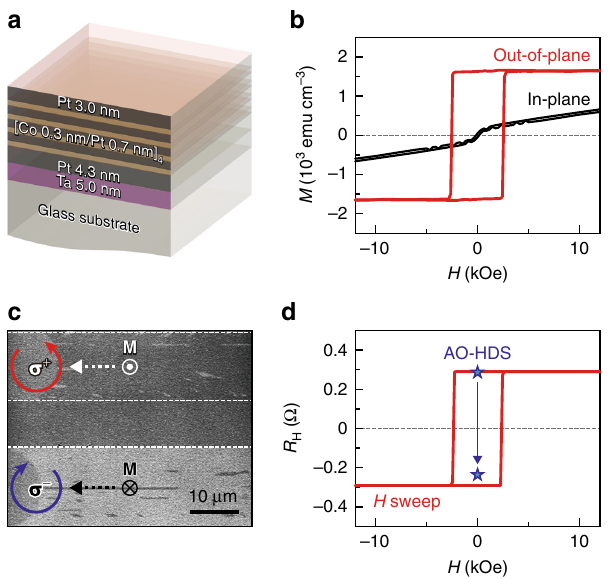
Fig. 2 Magnetic and magneto-optical properties of Co/Pt multilayer. a Layer con fi guration of the [Co/Pt] 4 multilayer fi lm. b Magnetization M curves of the [Co/Pt] 4 sample, measured when the magnetic fi eld H was applied along the easy axis (out-of-plane direction of the fi lm) and the hard axis (in-plane direction of the fi lm) at room temperature. The [Co/Pt] 4 sample exhibits the strong perpendicular magnetic anisotropy with an out- of-plane coercive fi eld of 2.3 kOe and an anisotropy fi eld of 41.9 kOe. c Magneto-optical Kerr effect microscopy image of the [Co/Pt] 4 sample illuminated with right ( σ + ) and left ( σ − ) circularly polarized light at room temperature. The dark (bright) contrast represents the area with M along the upward (downward) direction perpendicular to the fi lm plane. d Hall resistance R H of the [Co/Pt] 4 sample with a Hall cross shape at room temperature. The red line shows the out-of-plane H dependence of R H . The blue star data points were measured before and after illuminating the whole Hall cross with σ − light at zero fi eld, where the cross was uniformly magnetized by an external fi eld of H = + 20 kOe before the light